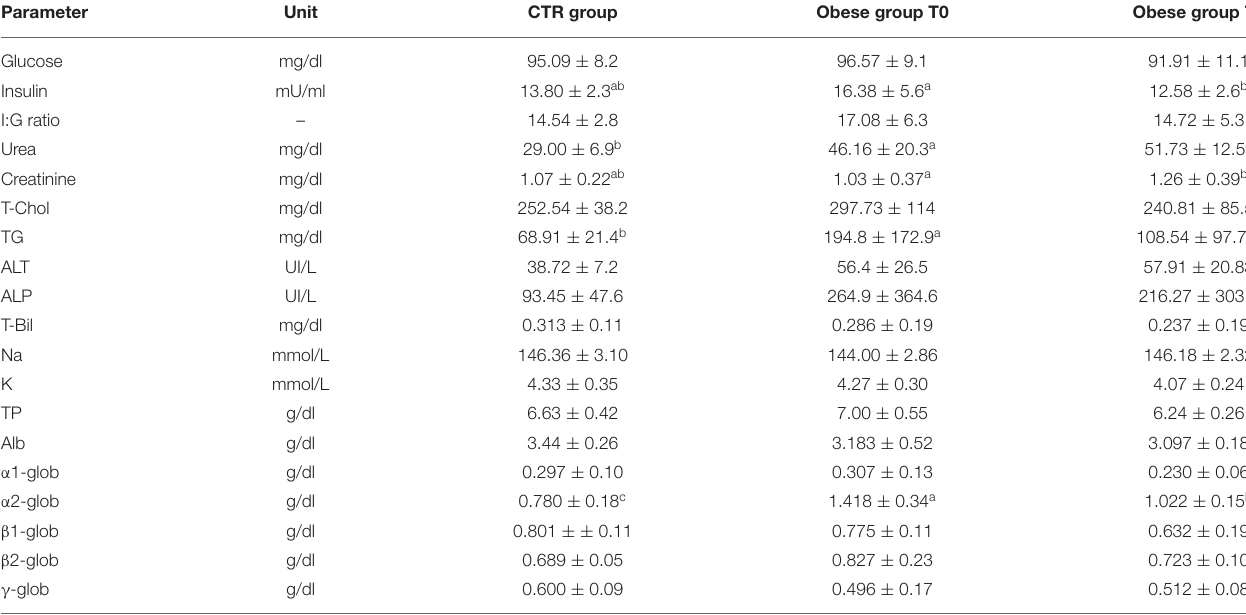
TABLE 2 | Biochemical profile in the control (CTR) group and obese group before and after the weight loss program (WLP). Parameter